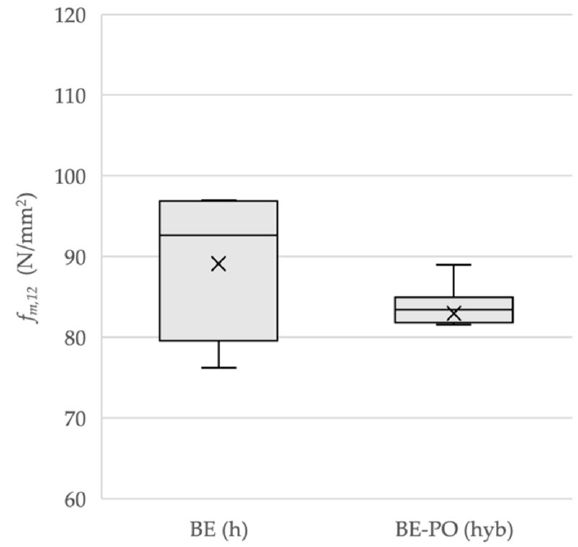
Figure 10. Experimental results expressed in a box plot. Table 1. Bending strength of the glue-laminated beams.